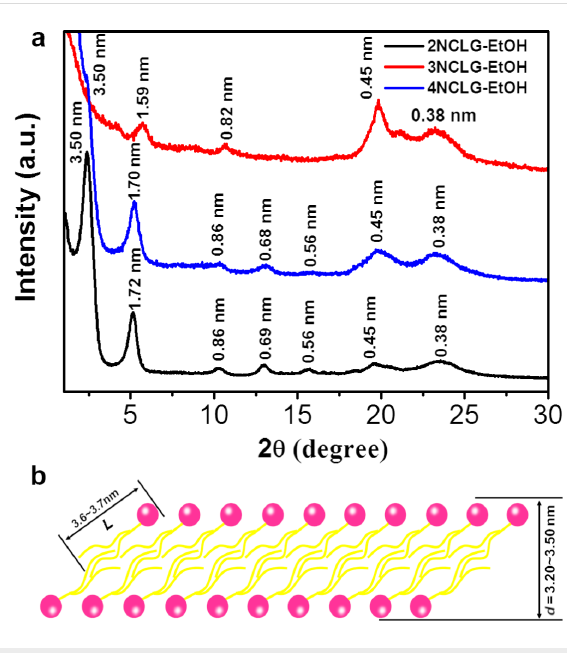
Figure 4: (a) XRD patterns of the 2NCLG assembly (black), 3NCLG assembly (red) and 4NCLG assembly (blue). (b) Proposed packing model of the three molecules.